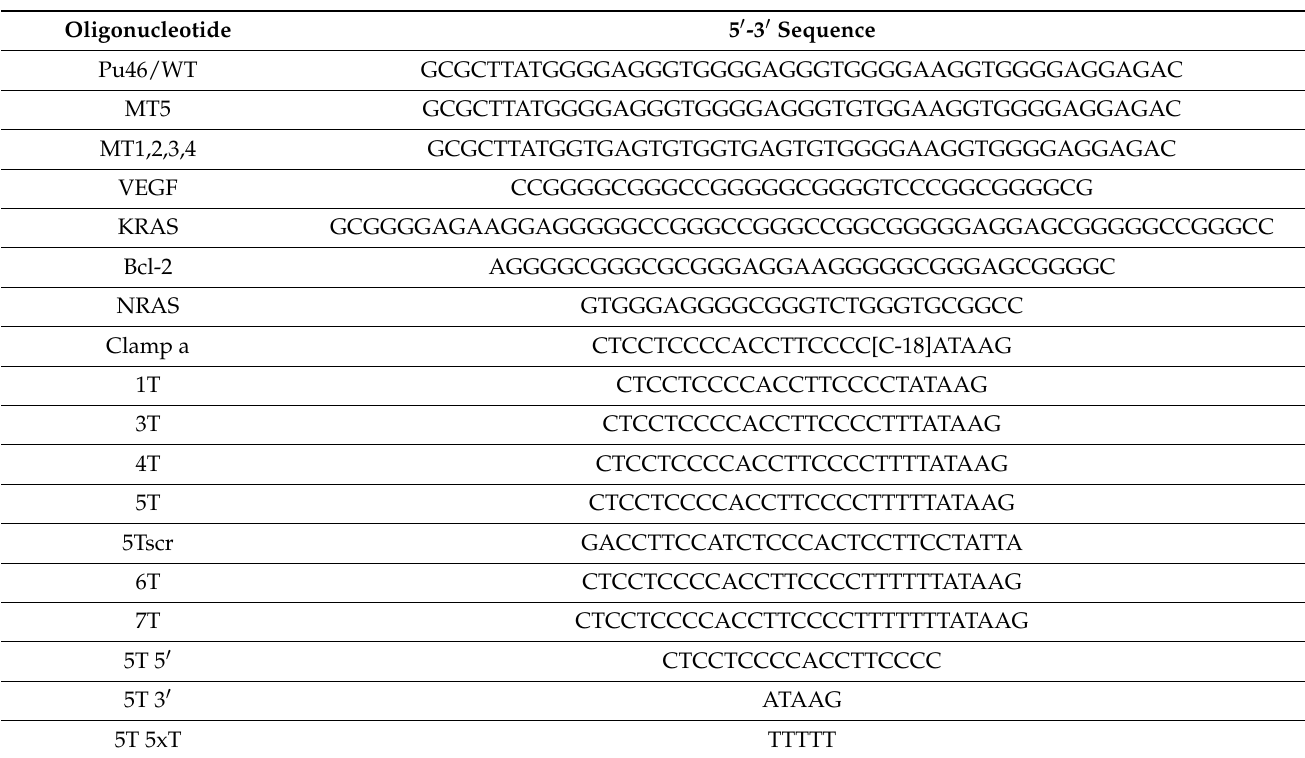
Table 2. DNA sequences used in the current study. Continuous runs of three or more guanines are underlined.